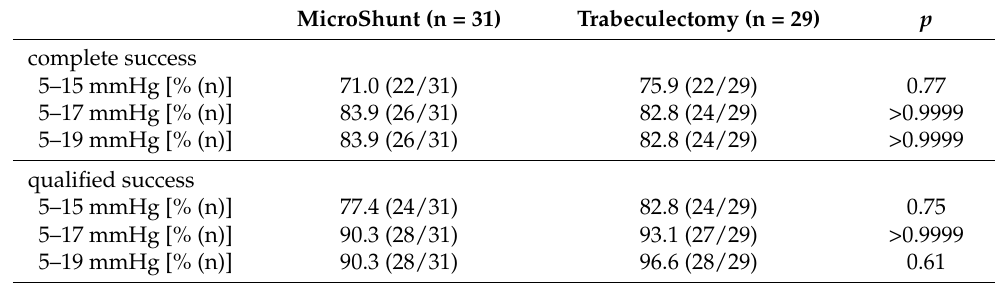
Table 2. Surgical success rates.